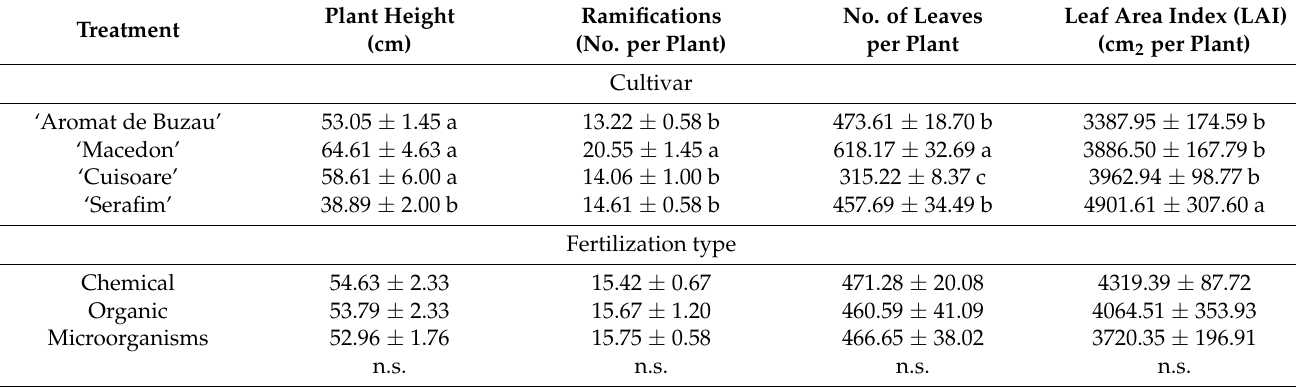
Table 2. Influence of cultivar and fertilization type on the biometric